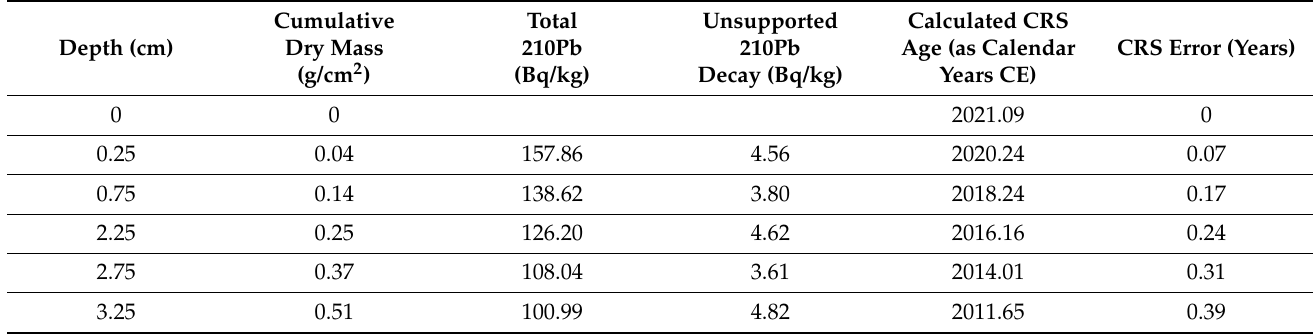
Table 1. Lead-210 results and Constant Rate of Supply (CRS) model